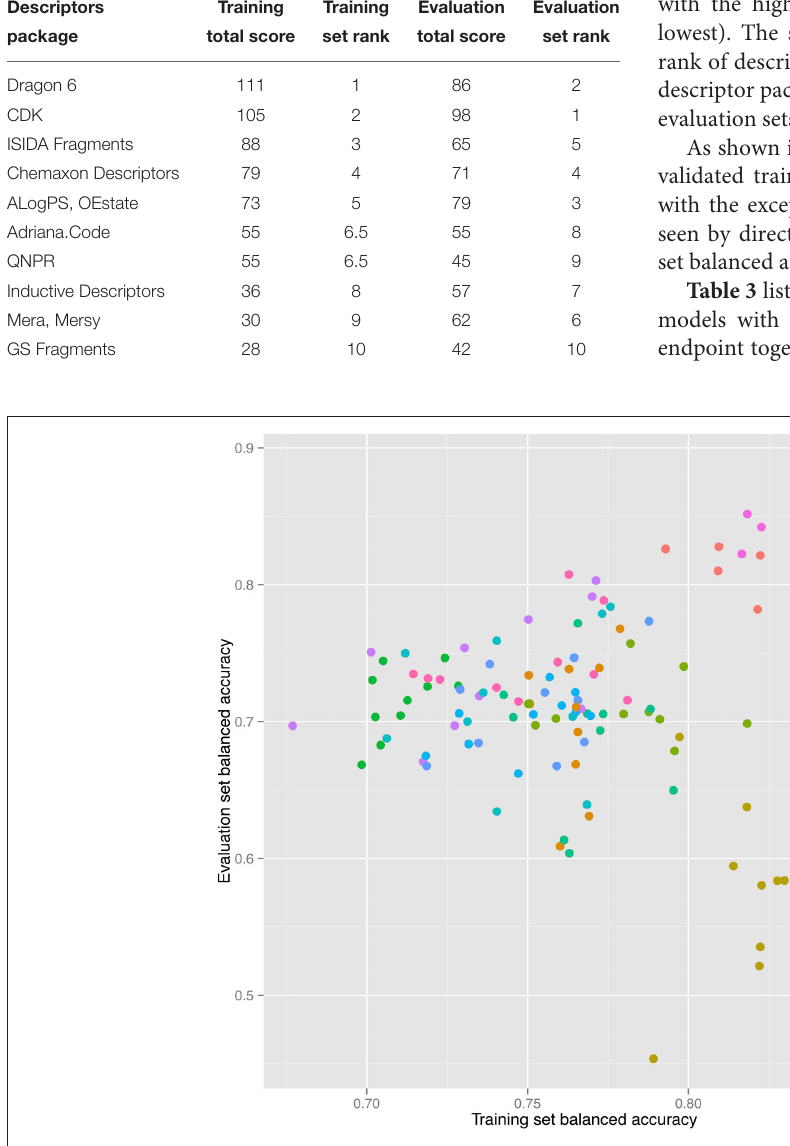
FIGURE 3 | Correlation between training and validation set balanced accuracies for 120 models constructed for 12 endpoints using 10 individual descriptor packages for each endpoint.